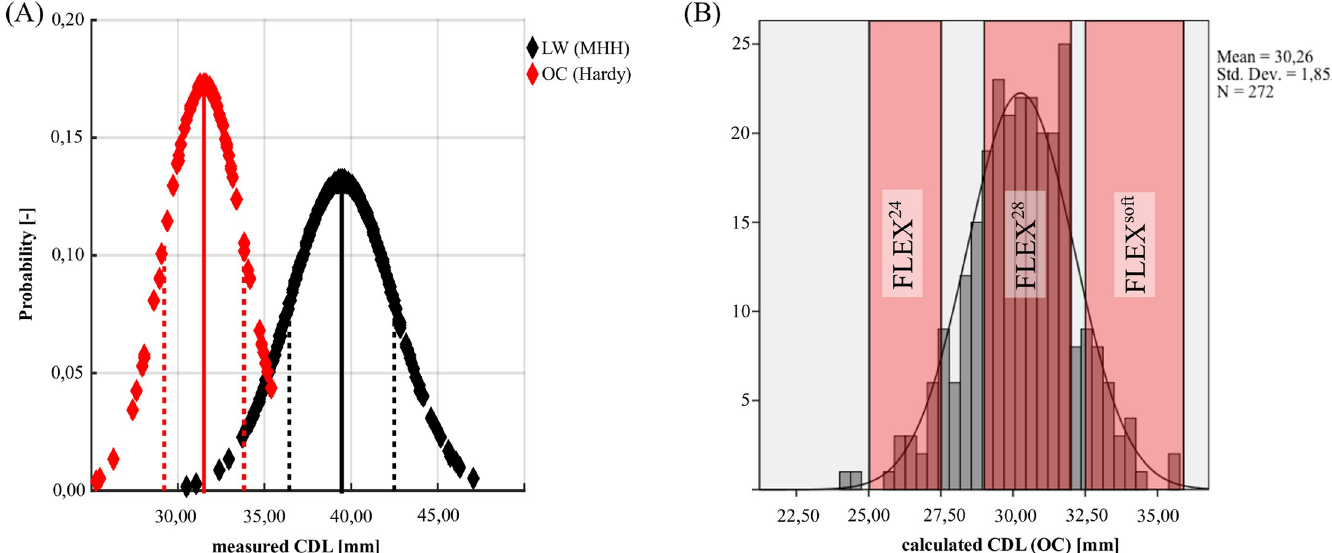
Fig 9. Organ of Corti length. (A) Histogram of the organ of Corti (OC) derived by Hardy and Lee (red) and MHH data (black), (B) Histogram of calculated OC length for MHH data with electrode lengths for FLEX 24 , FLEX 28 and FLEX Soft (+/- 5%).